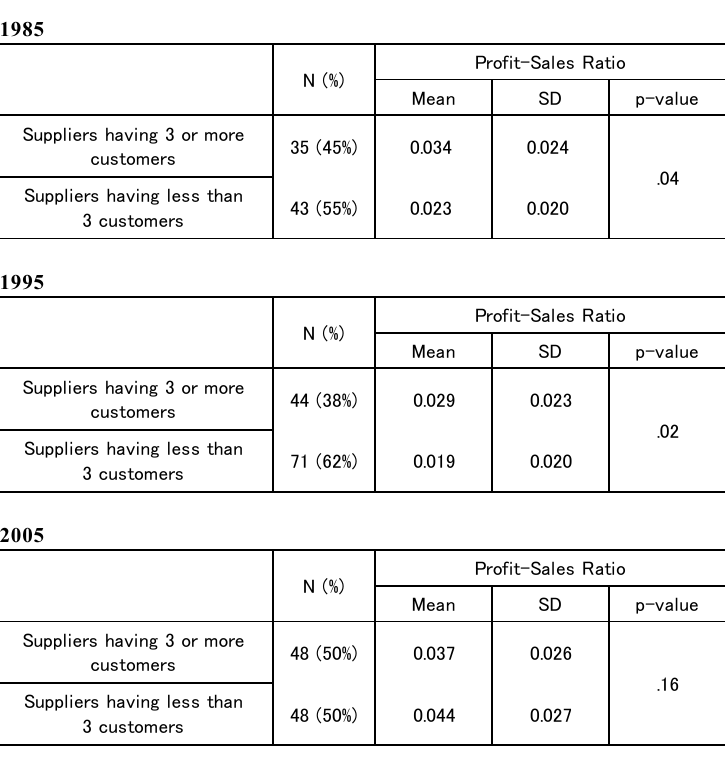
Table 5. Comparative analyses ( t -test): Profit–sales